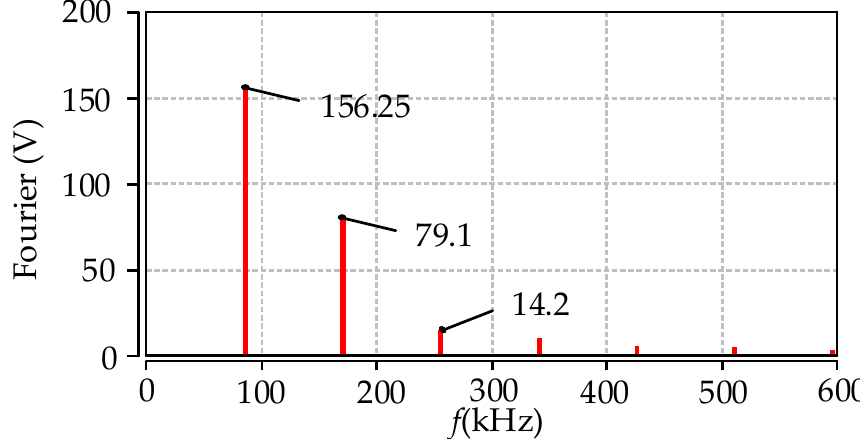
Figure 13. The curves of G v ( f ) and G i ( f ) versus driving frequency.